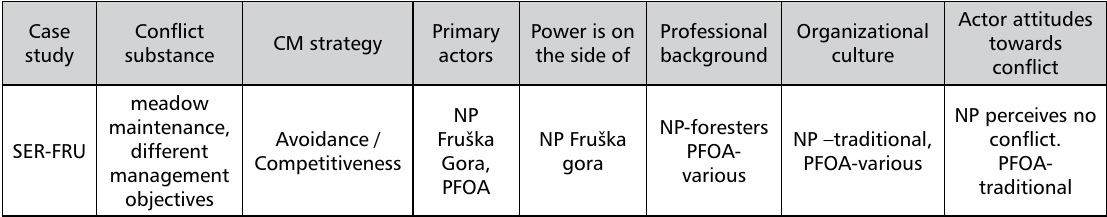
Conflict management elements data outlined per case studies Case